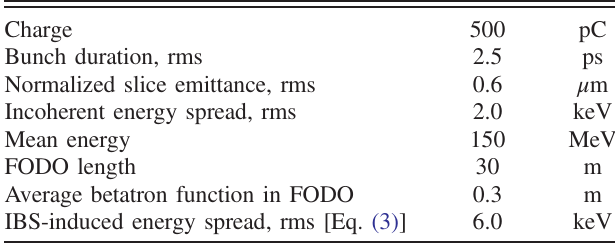
TABLE I. Electron beam parameters out of a state-of-the-art photoinjector and FODO lattice